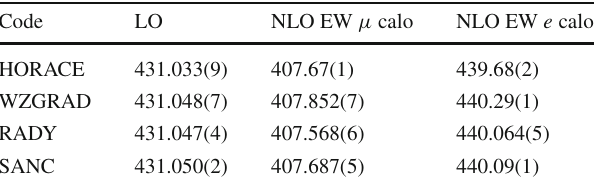
Table 8 Tuned comparison of total cross sections (in pb) for pp → γ, Z → l + l − + X at the 8 TeV LHC, with ATLAS/CMS cuts and calorimetric